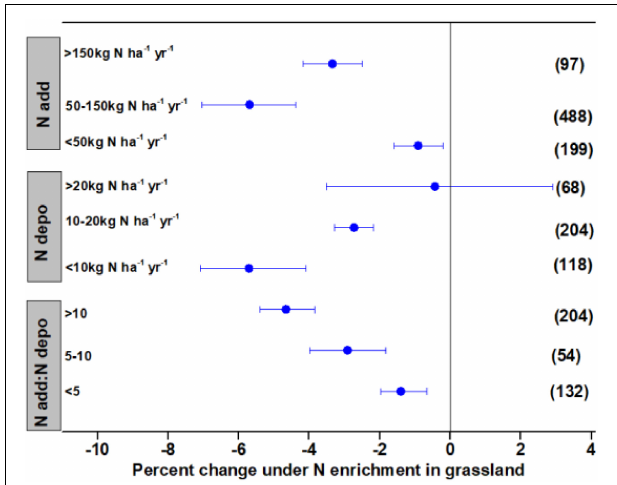
FIGURE 2 | Mean percent change of litter mass remaining after N enrichment, ambient N deposition, and the ratio of N addition:ambient N deposition in grassland. Differences in mean levels were regarded as significant if the 95% CIs did not overlap zero. Values in brackets represent the number of observations for each ecosystem